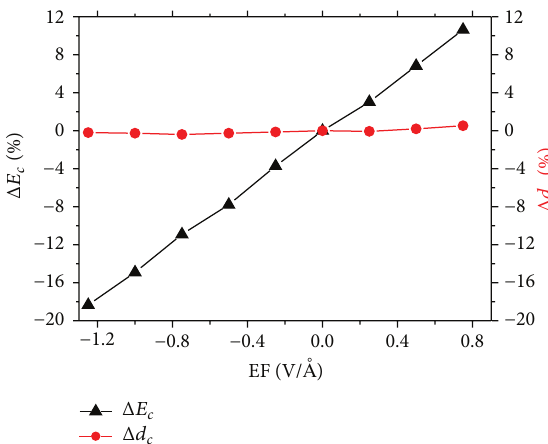
Figure 7: Effects of EF on chemisorption energy and bond distance of chemisorption.